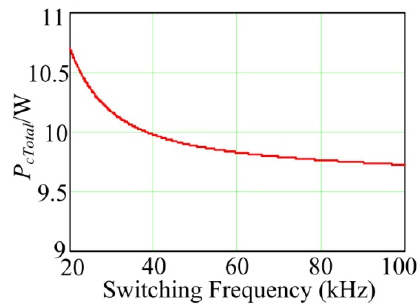
Figure 3. Switching frequency effect on the conduction losses at I o = 10